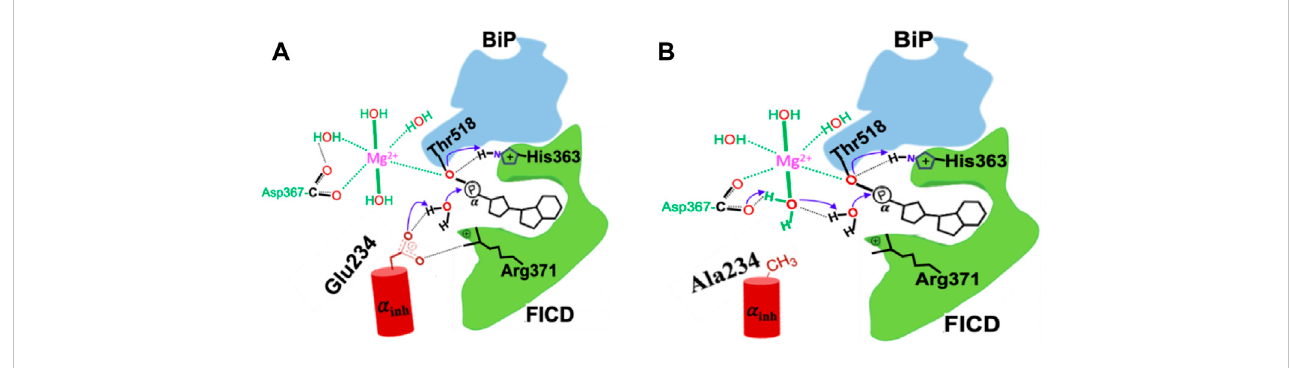
Overall deAMPylation mechanism with FICD in the wild type (A) and Glu234Ala mutants (B)